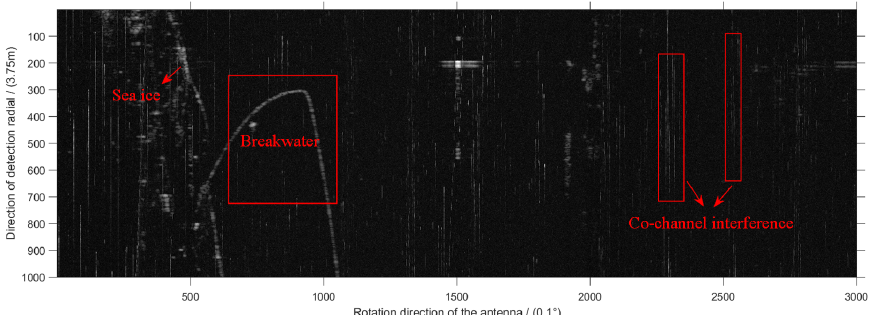
Figure 1. Original radar image in Cartesian coordinate system.